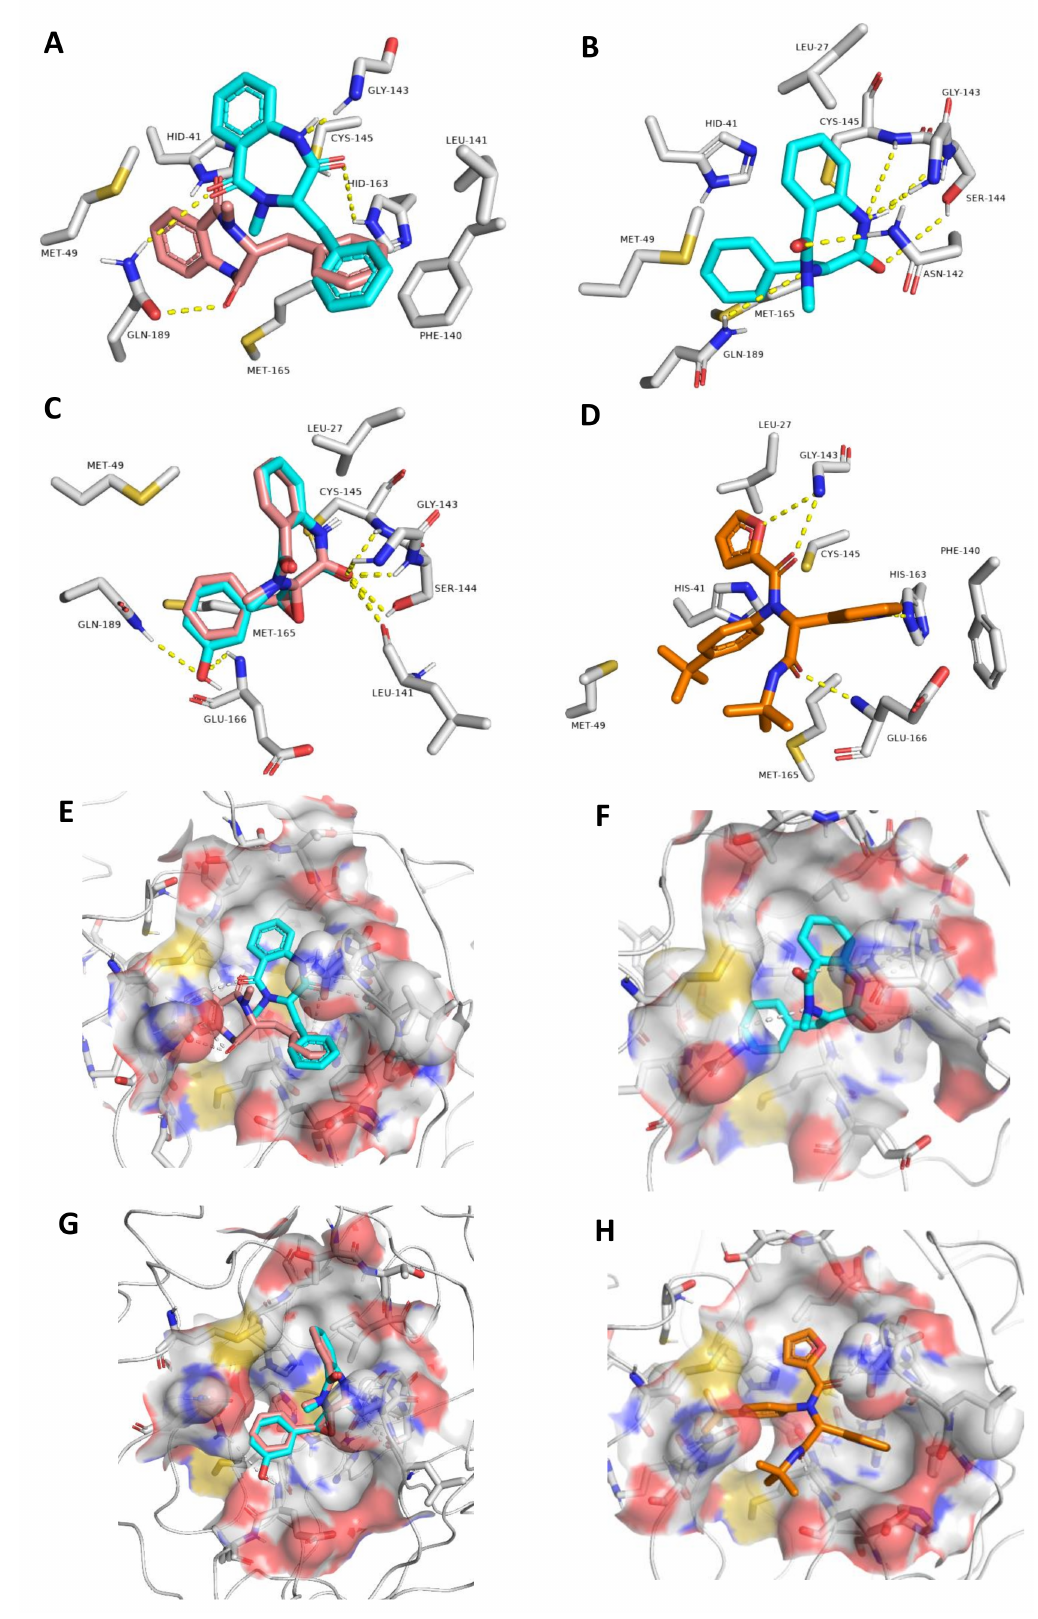
Figure 5. Different binding modes of compounds 1 – 4 ( A – C and E – G , respectively). The S-isomer of compound 1 ( A , E ) is cyan, while the R-isomer is brick red. Compound 3 has a brick red hue, while compound 4 has a cyan hue ( C , G ). The co-crystallized ligand ( D , H ) are shown in